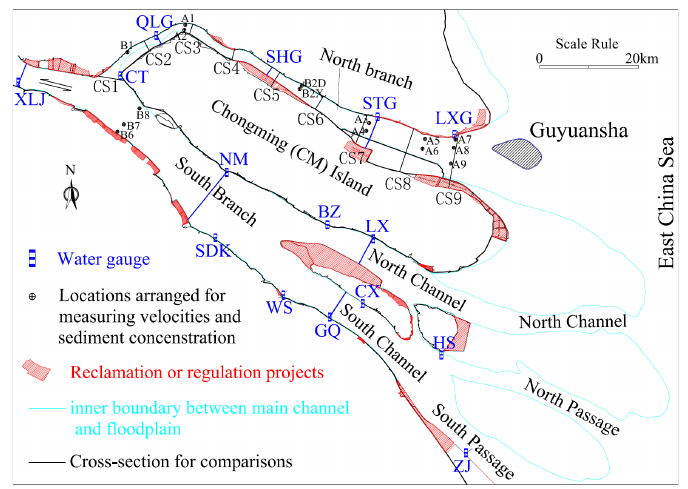
Figure 3. Arrangements of hydrology survey locations in Yangtze Estuary.